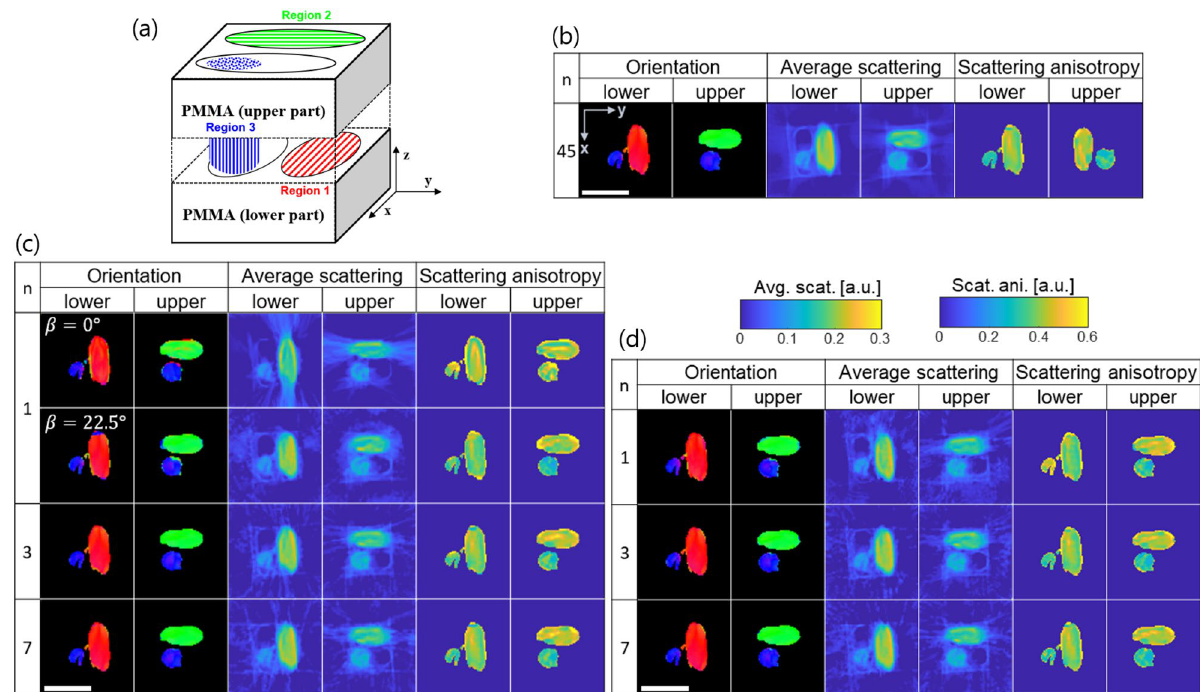
Figure 6. Visualisation of the reconstructed volumes for the validation sample. The validation sample ( a ) with three carbon fibre bundles in a polymethyl methacrylate (PMMA) box oriented orthogonal to one another. Axial slices through the lower and the upper part of the validation sample reconstructed from the data acquired with the reference ( b ), the stairwise ( c ) and the spiral ( d ) acquisition protocols. Fibre orientation, average scattering and scattering anisotropy values are shown for each acquisition scheme. Scale bar: 4